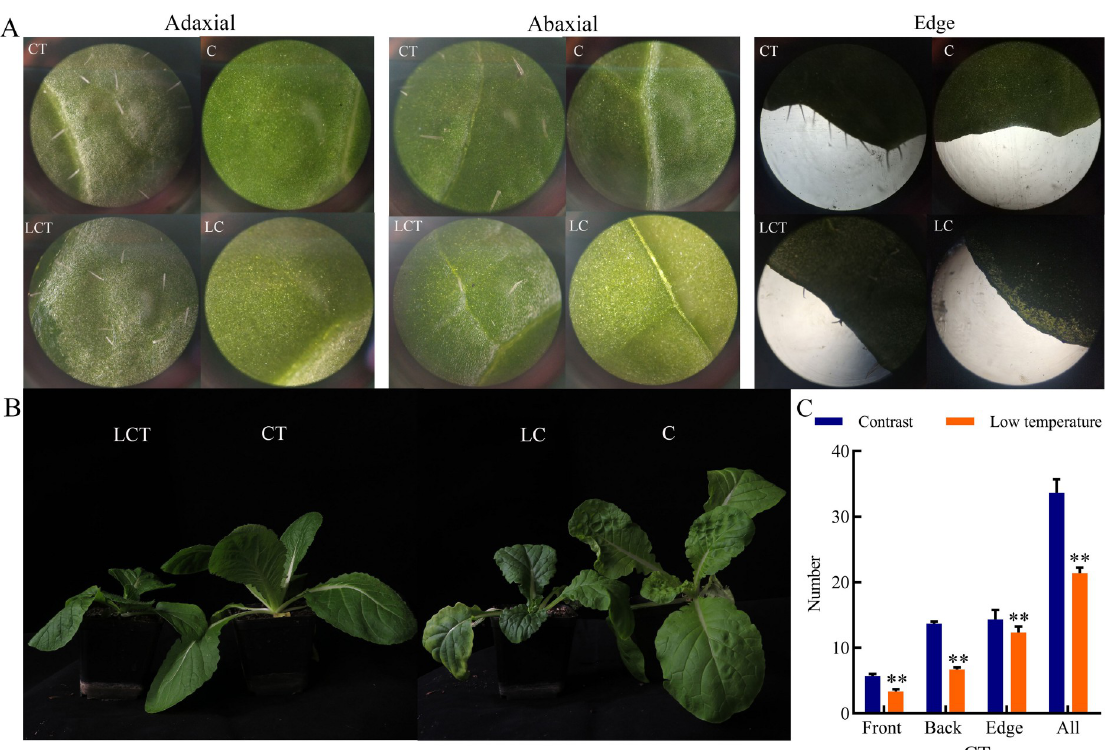
Fig 1. Effect of low temperature treatment on trichomes. A, Three visual fields (adaxial, abaxial, and edge) at room temperature (CT, C) and low temperature (LCT, LC); B, Plants at room temperature (CT, C) and low temperature (LCT, LC); C, Density of trichomes at room temperature (CT) and low temperature (LCT).